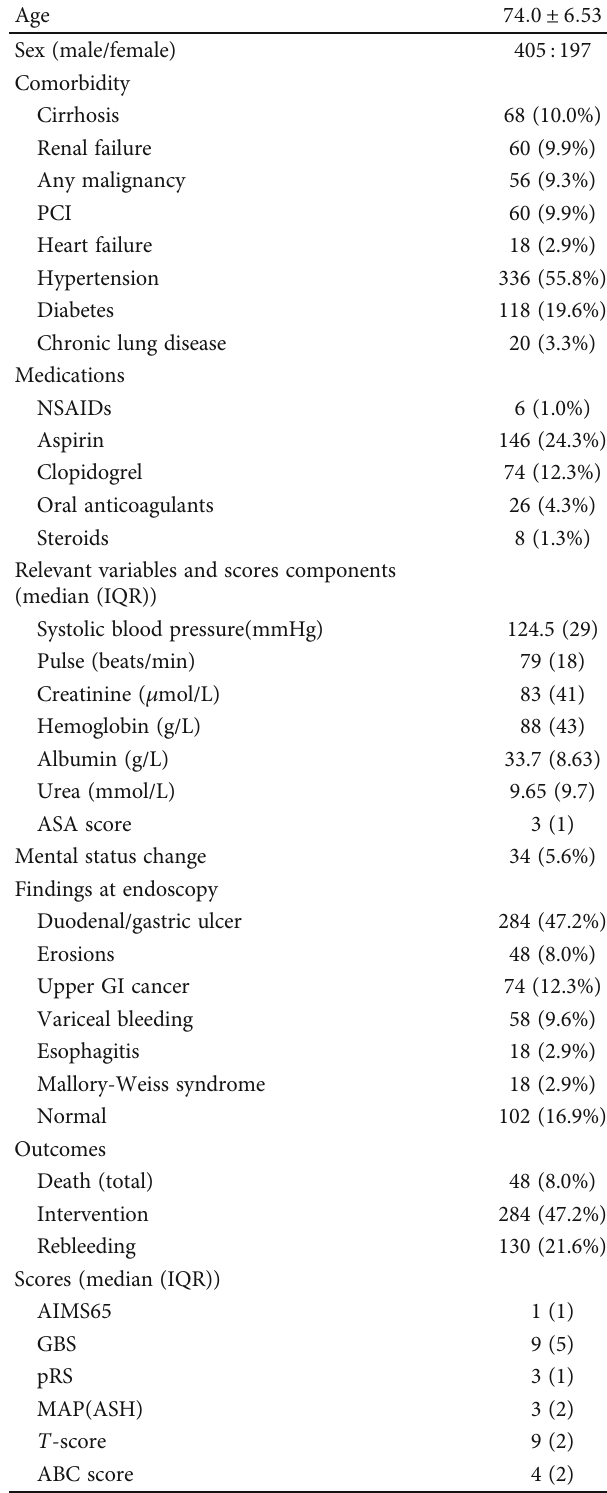
Table 1: The ABC score.